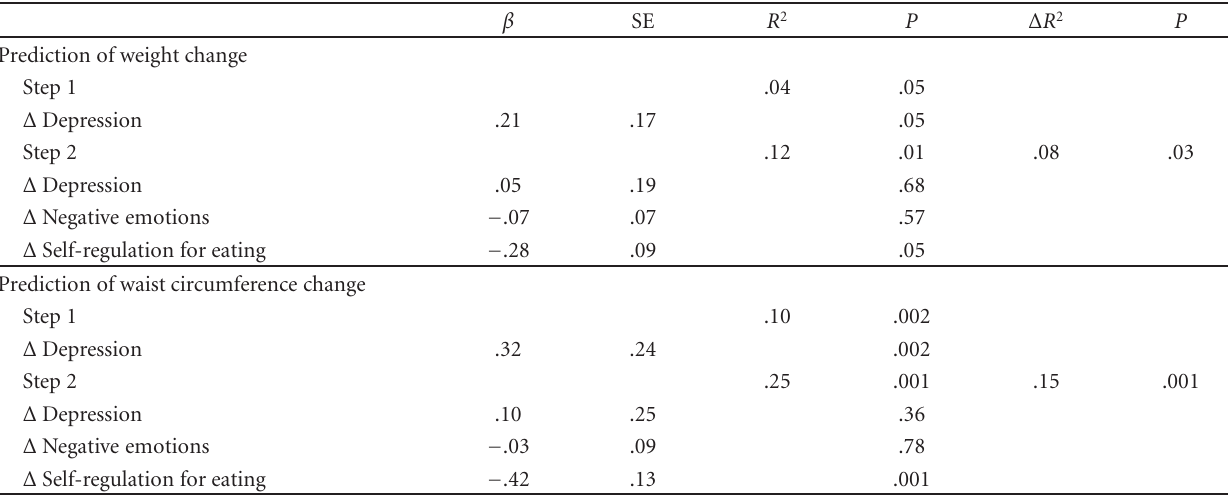
Table 1: Changes in measures over 24 weeks in an investigation on exercise and emotionaleating with severely obese women, 2011 ( N = 88). Baseline Measure Depression Negative emotions Self-regulation for Weight (kg) Waist circum. (cm)